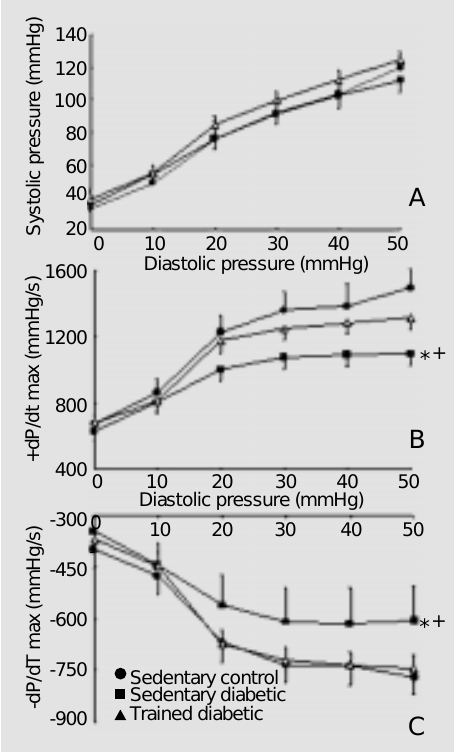
Figure 2 - Influence of diastolic pressure on systolic pressure (A), maximum rate of rise (+dP/ dt max) (B), and maximum rate of fall (-dP/dt max) (C) developed by the left ventricle of hearts iso- lated from sedentary control, sedentary diabetic and trained diabetic rats. Data are reported as means ± SEM. *P<0.05 com- pared to sedentary control rats; + P<0.05 compared to sedentary diabetic rats